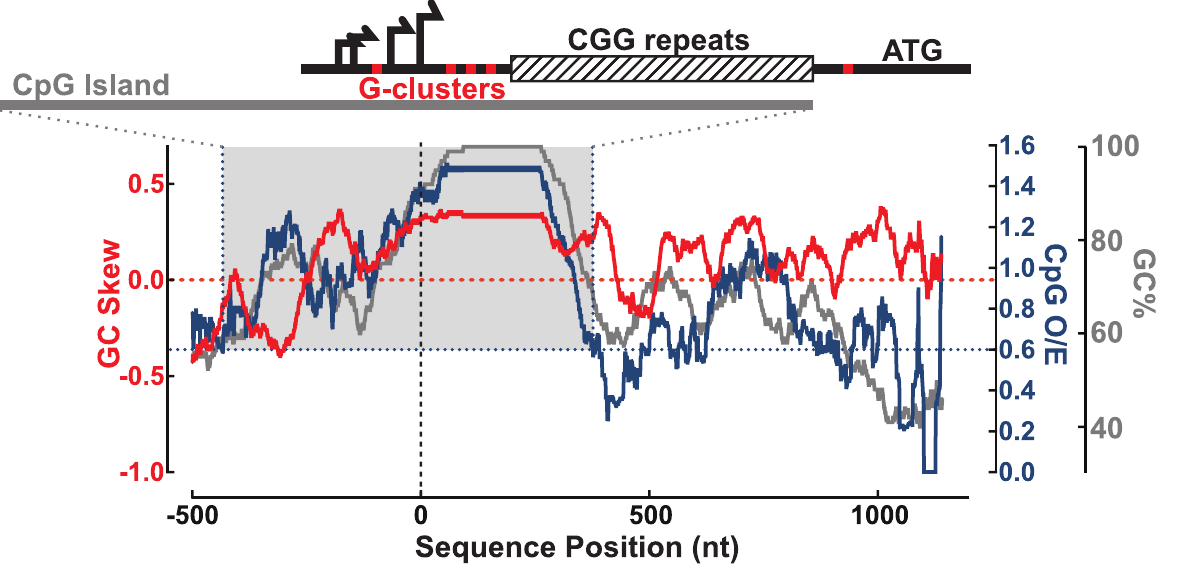
Figure 1. Sequence analysis of the FMR1 promoter reveals signatures of R-loop formation. GC skew (red, left y-axis), CpG observed/ expected ratio (CpG O/E; navy, right y-axis), and GC% (gray, right y-axis) calculated over a sliding 100 nt window from 2 500 to + 1200 nt around the downstream-most known transcription start site (vertical dotted line). Gray-shaded box highlights CGI defined by CpG O/E . 0.6 (navy dotted lines) and GC% . 50% for at least 200 nt. Schematic at the top shows the FMR1 5 9 UTR with multiple transcription start sites (black arrows), G-clusters (red ticks), and CGG repeats (striped box), all overlapping the CGI (gray bar) for scale to the graph below.